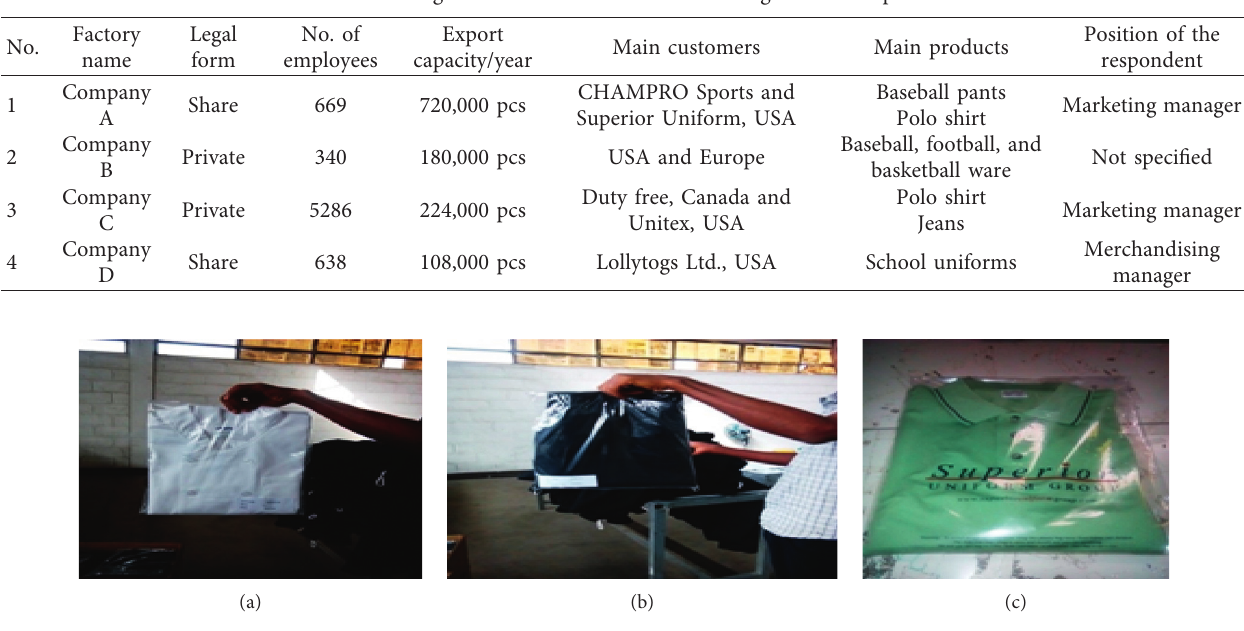
Figure 1: Physical garment samples which are ready to be sent to buyers for approval (photo taken from company